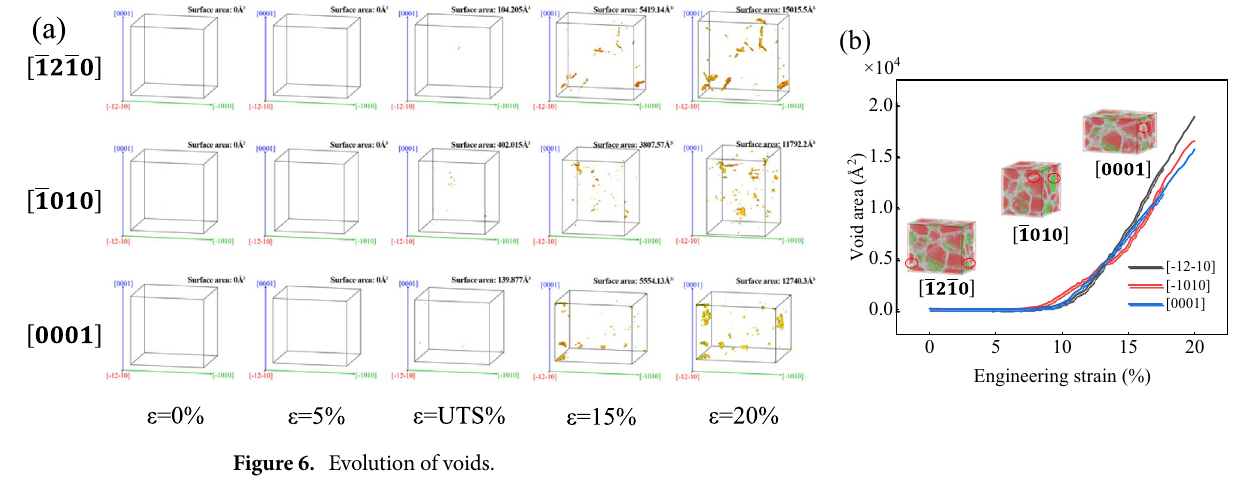
Figure 6. Evolution of voids.